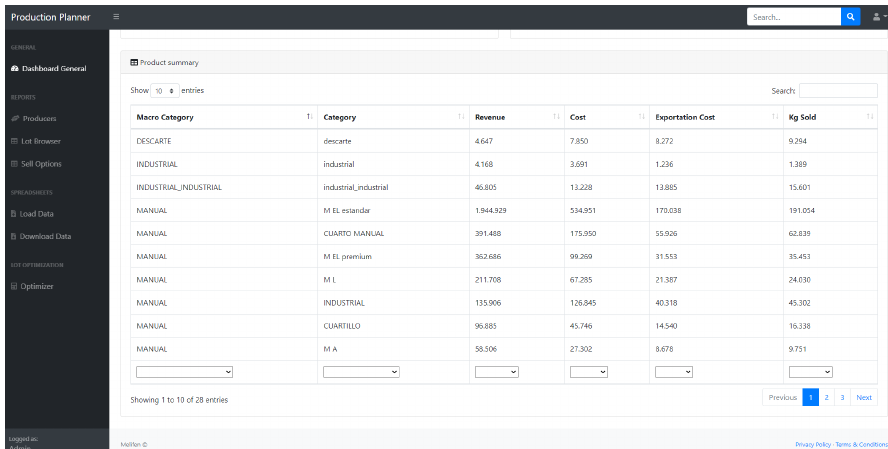
Figure 8. Dashboard summary by